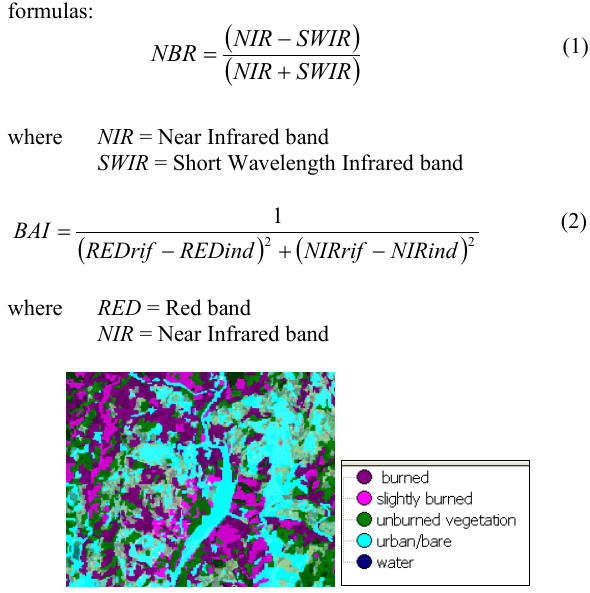
Figure 5. Classification of Landsat data in a highly compromised area - third